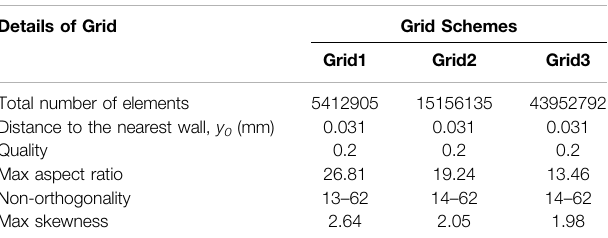
TABLE 1 | The study of grid